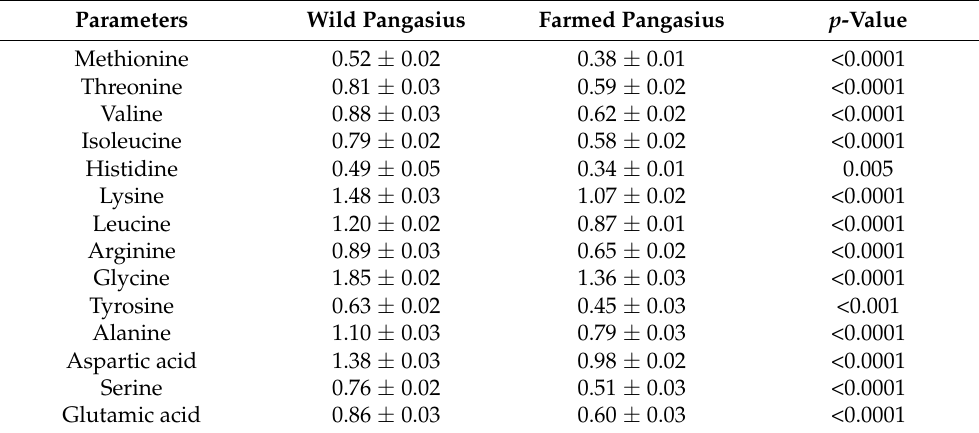
Table 2. Amino acid compositions of the wild and the farmed pangasius catfish muscles (g/100 g of total amino acids; wet basis).